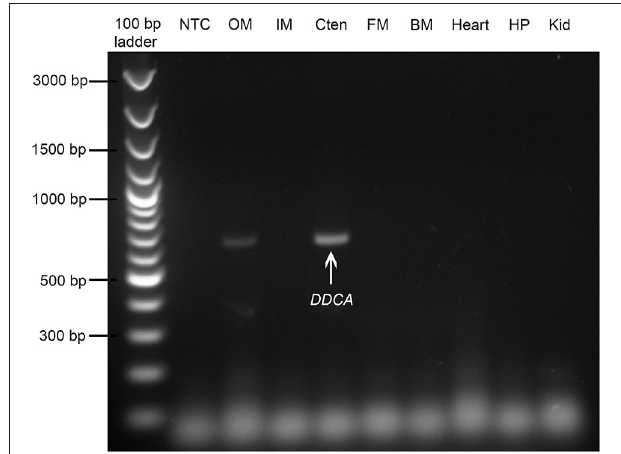
FIGURE 3 | Gene expression of the Dual Domain Carbonic Anhydrase ( DDCA ) in tissues/organs of Tridacna squamosa . The mRNA expression of the DDCA in the outer mantle (OM), inner mantle (IM), ctenidium (Cten), foot muscle (FM), byssal muscle (BM), heart, hepatopancreas (HP), and kidney (Kid) of T. squamosa kept in darkness for 12h (control). A negative control (NTC) was included in the first lane.